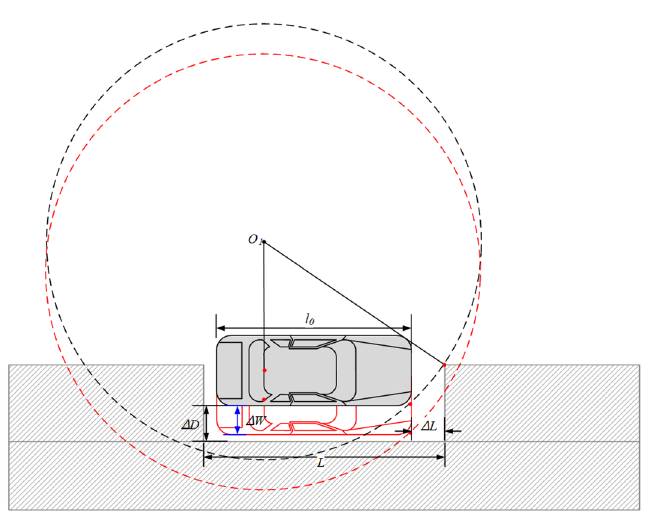
Figure 9. Repetitive (𝑆 (cid:2878) 𝑅 (cid:2879) 𝐿 (cid:2879) ) parallel parking model.